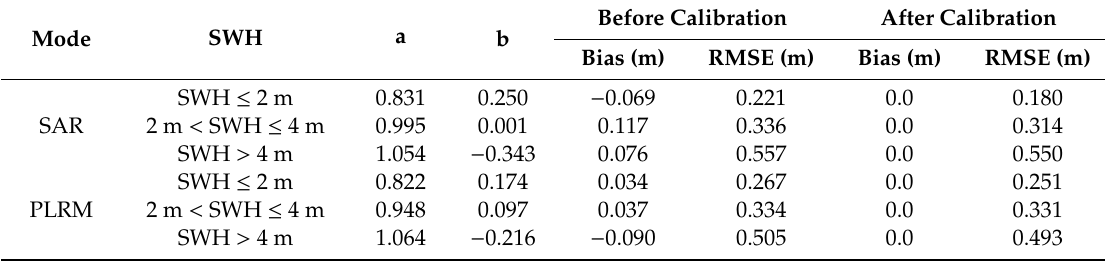
Table 2. Coefficients of calibration functions and statistical parameters of Sentinel-3A SWH data.